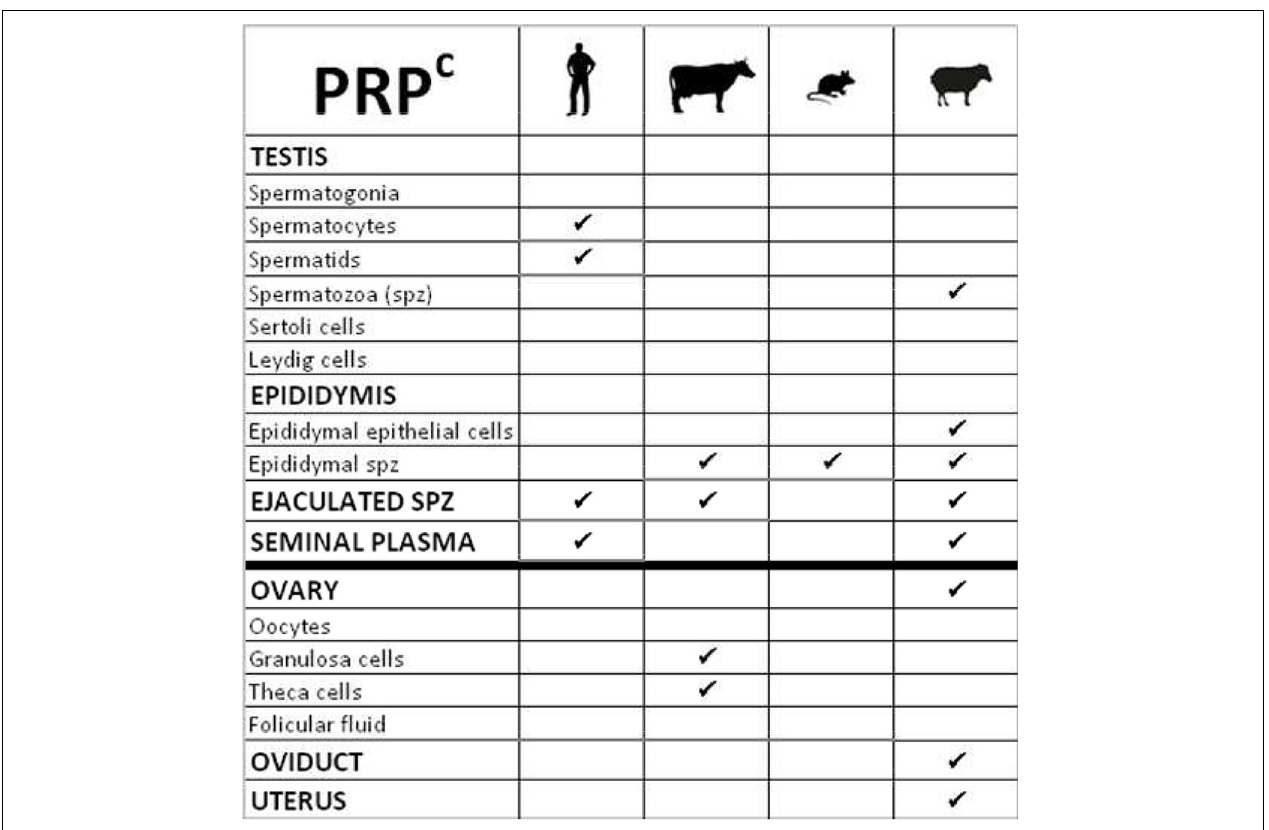
FIGURE 6 | Table summarizing the cellular localization of Prion protein (PRP c ) in gonads of various species.